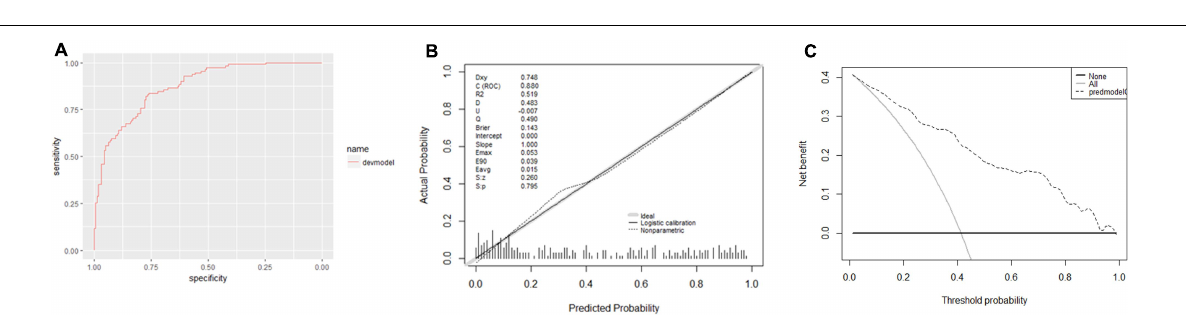
(Privé et al., 2019). Finally, a panel of optimal and representative variables are obtained (n344917 expression, age, CT calcification, cough, TB-IGRA, and low-grade fever and weight loss). Among